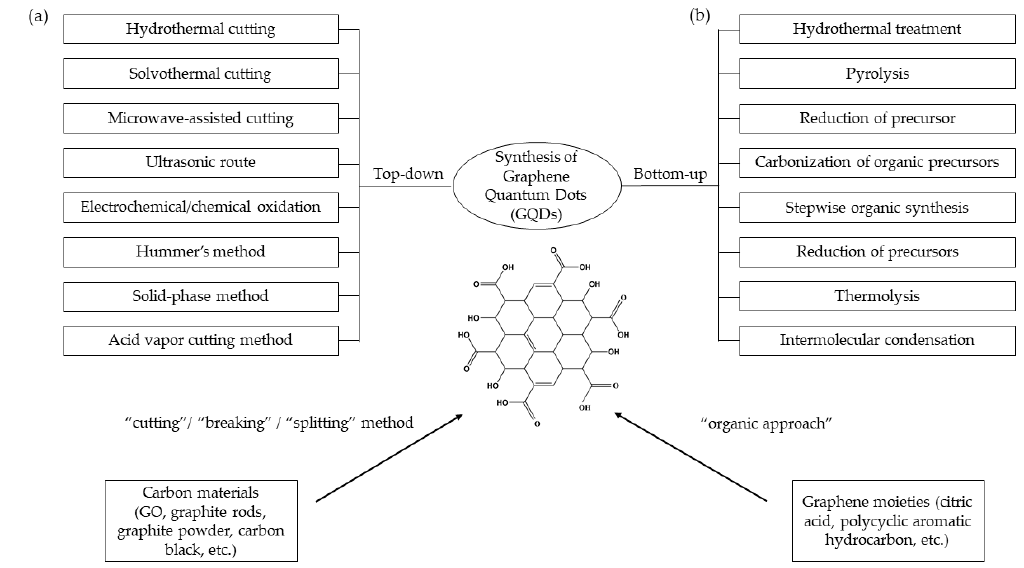
Figure 1. Representation of graphene quantum dots (GQDs) synthesized through ( a ) top–down methods and ( b ) bottom–up methods.